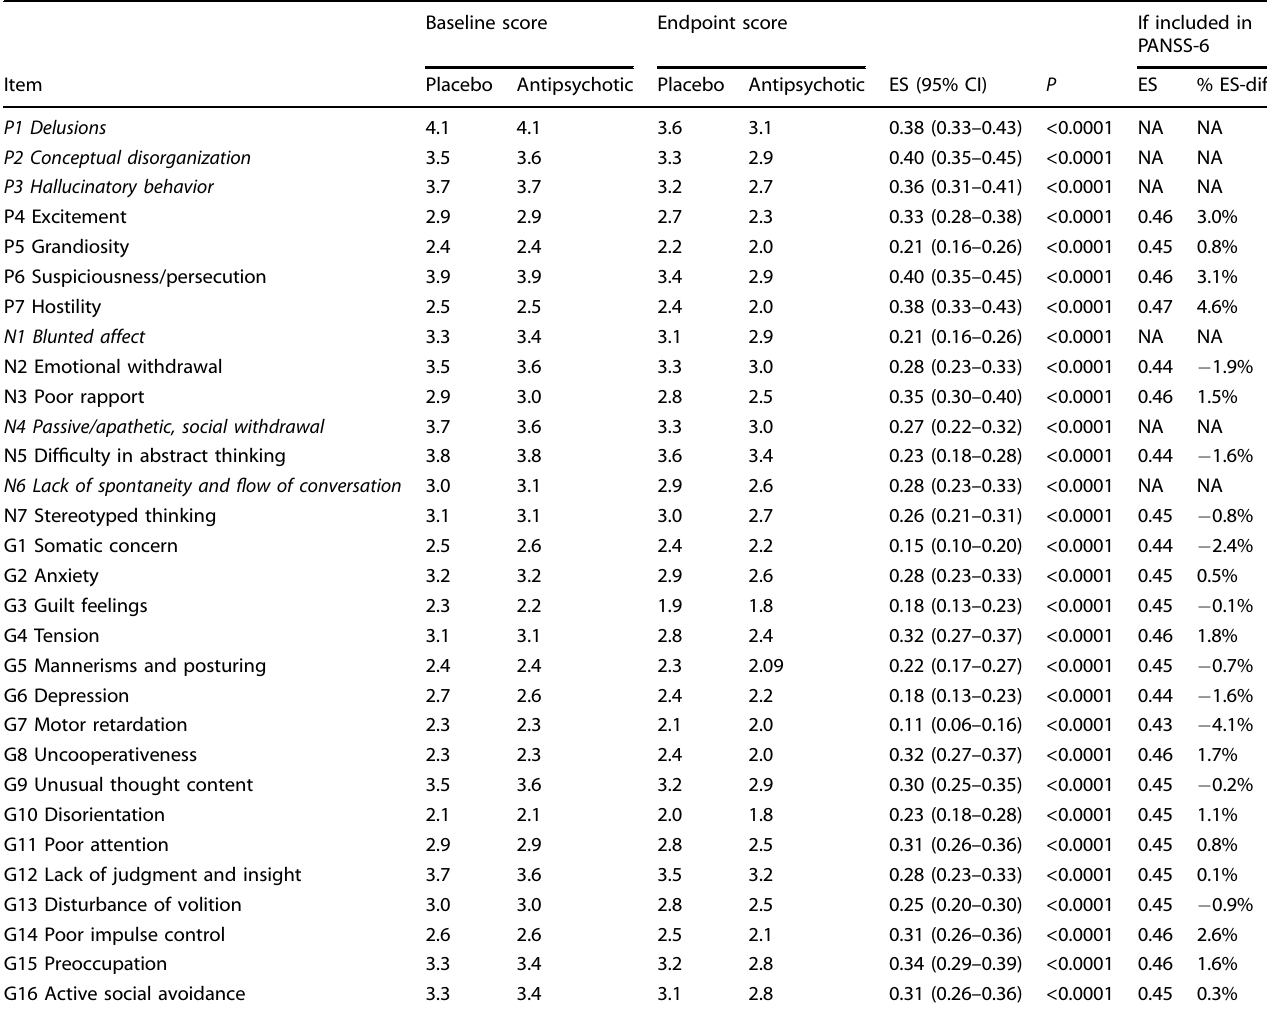
Table 4. Antipsychotic – placebo differences on individual PANSS-30 items (pooled population). Baseline